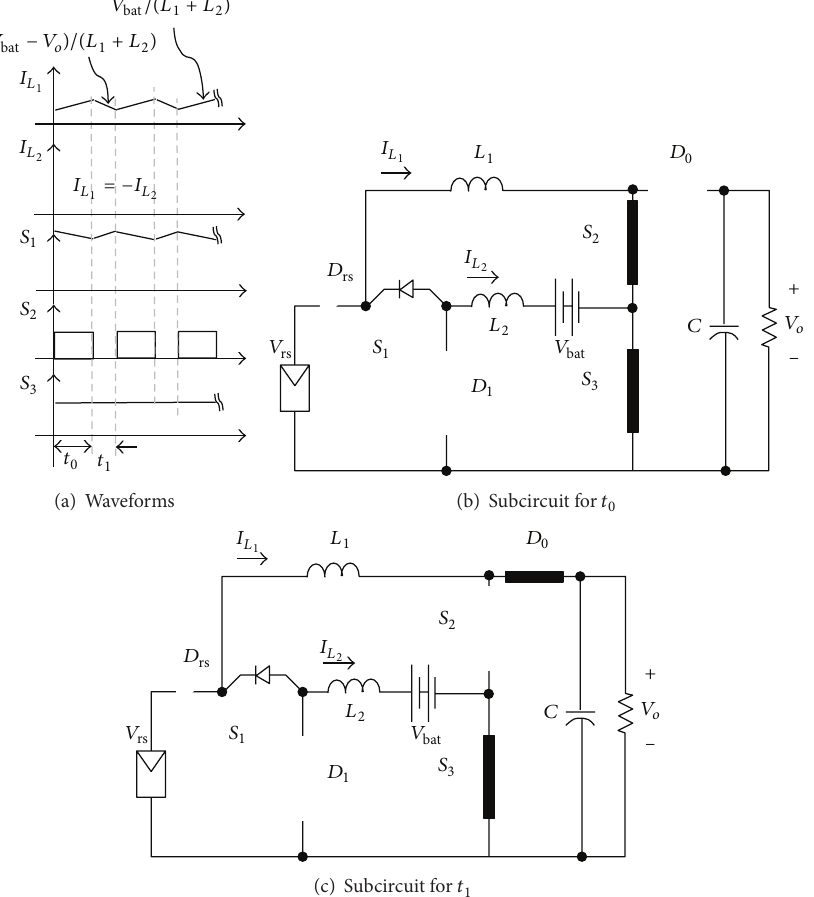
Figure 9: Waveforms and subcircuits when energy is supplied from the battery set (mode 2, only battery).